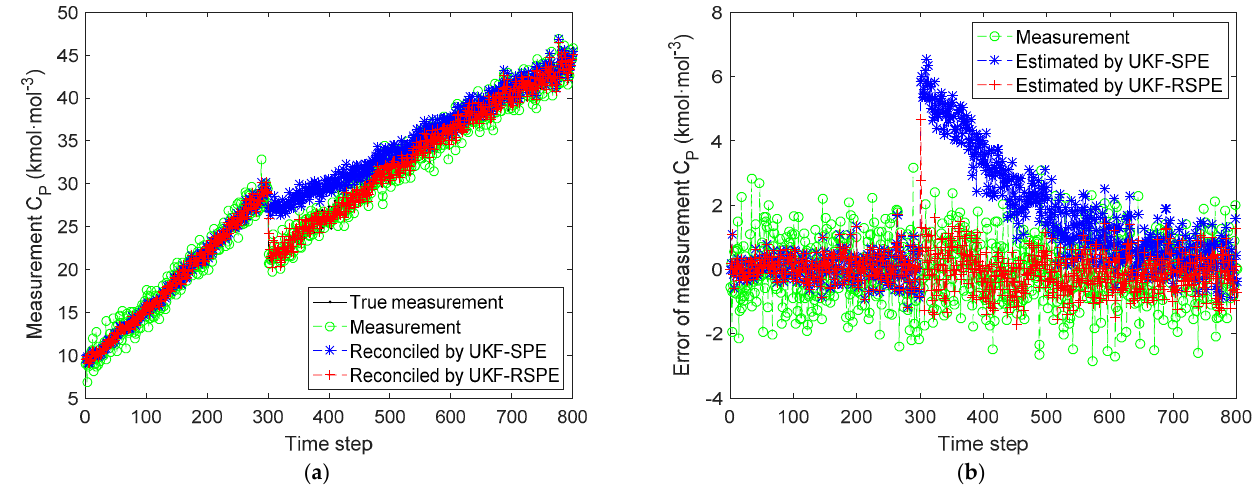
C in Case Study 2.1: ( a ) rec- p